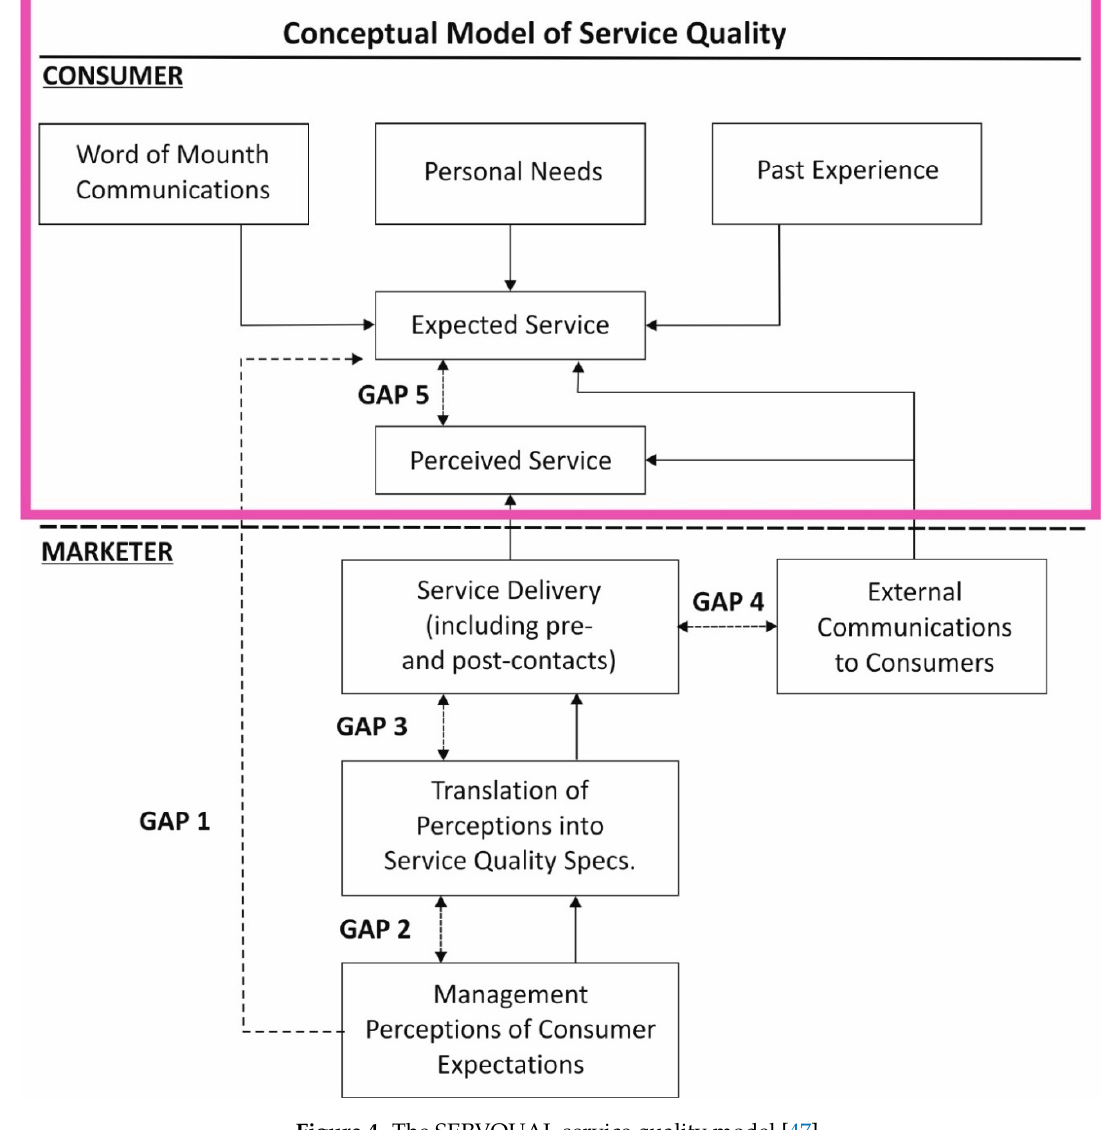
Figure 4. The SERVQUAL service quality model [47]. Table 2. Service quality dimensions in SERVQUAL